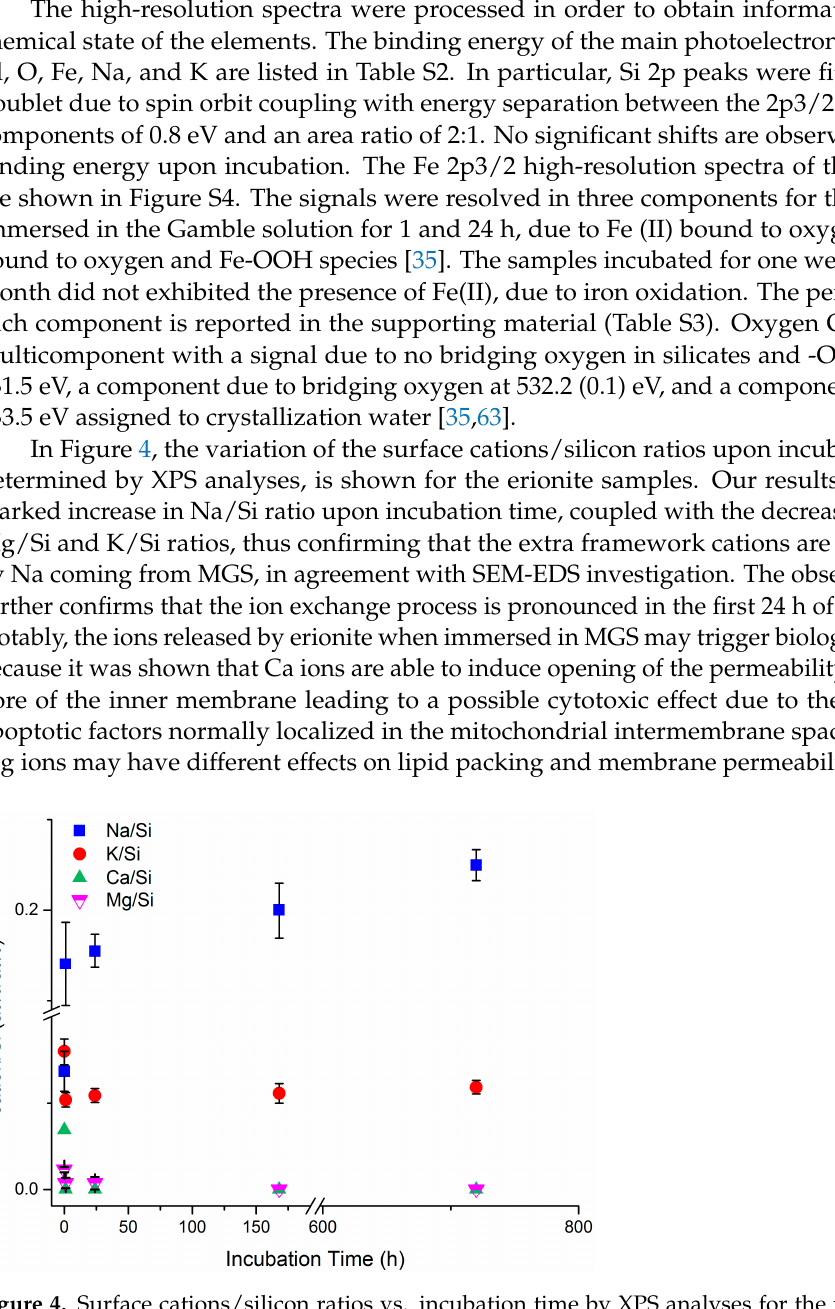
Figure 4. Surface cations/silicon ratios vs incubation time by XPS analyses for the investigated erionite samples. Table 3. Chemical analyses, by SEM-EDX, of both pristine and incubated erionite fibres for one hour (E-1H) and one month (E-1M) in the mimicked Gamble’s solution. In addition, data of pristine chabazite are reported. Chemical formulae were not calculated in the case of analyses characterized by E% exceeding 10%. Standard deviations are reported in parenthesis. Oxides (wt.%)